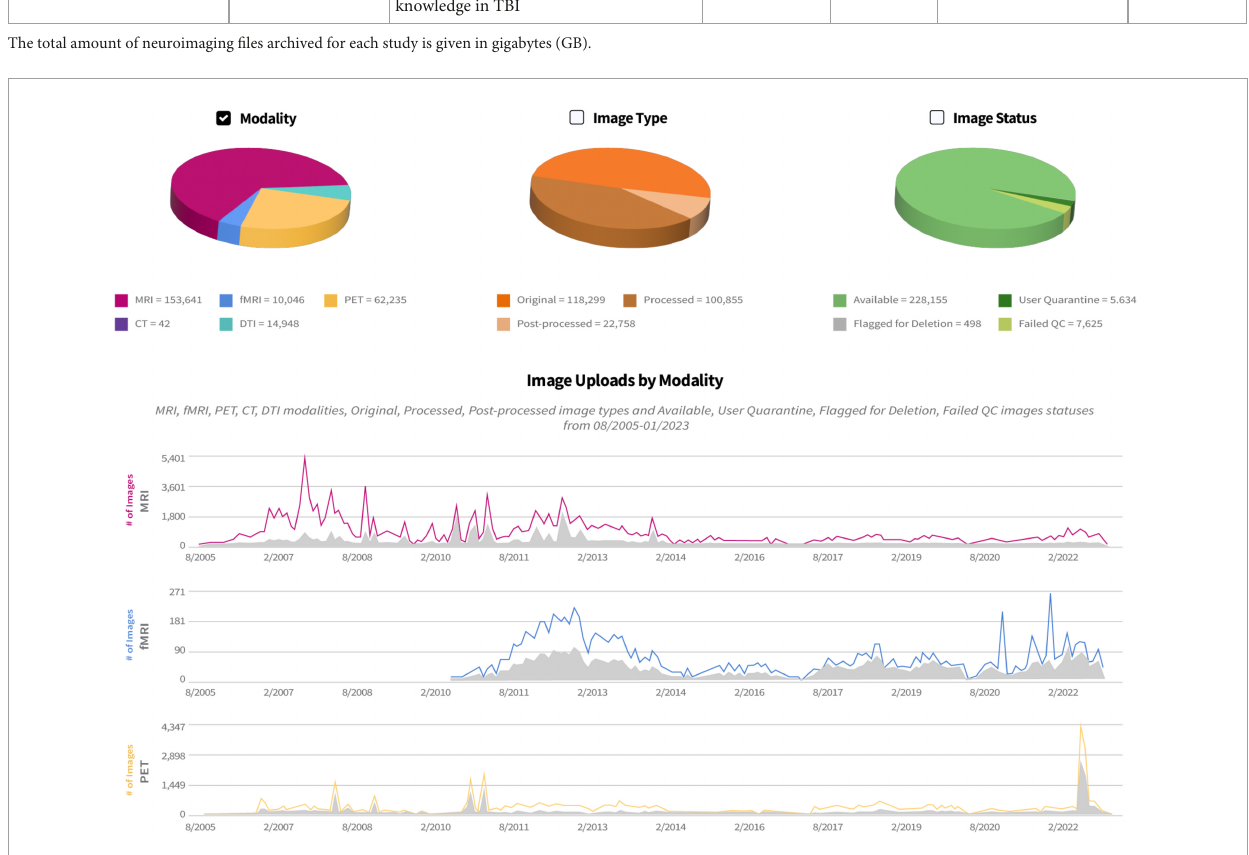
FIGURE2 IDA study management pages provide a history of uploads and downloads of each neuroimaging modality. Counts of image uploads are categorized as original (images archived directly from scanner), processed (images corrected for artifacts, etc.) quarantined (removed from general view), and failed (not passing quality